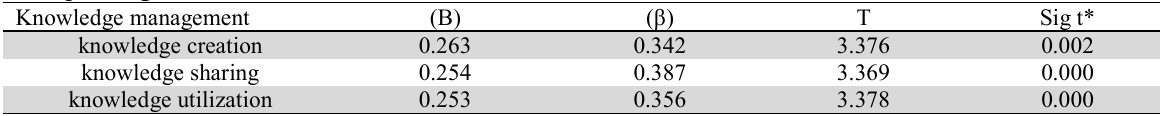
Multiple Regression of the H1 Knowledge